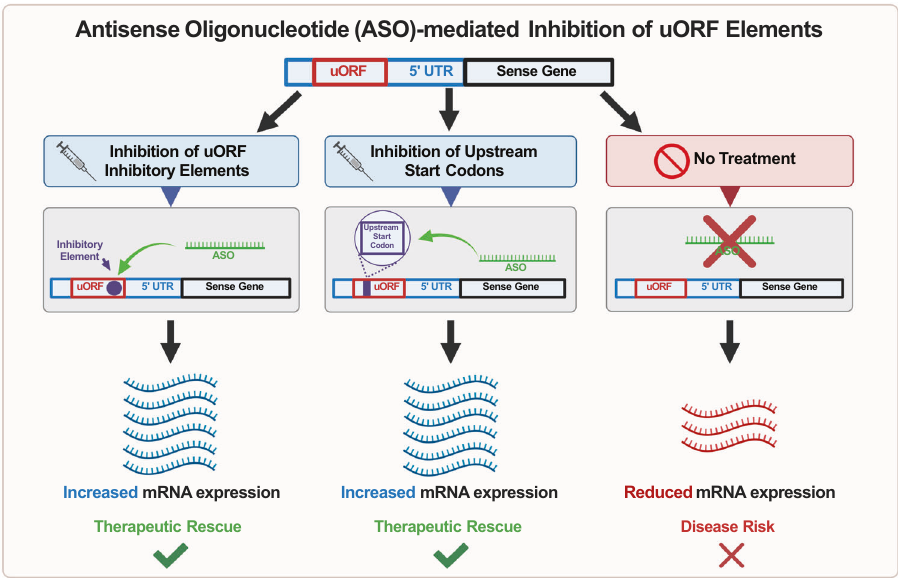
Fig. 3 Diagram of inhibitory antisense oligonucleotide (ASO) mechanisms. A ASOs can be used in the inhibition of the upstream start codon within the upstream open reading frame (uORF) of an mRNA transcript to increase translational expression of the target gene; B ASOs can be used to target and hybridize with inhibitory elements that form translation-inhibiting secondary structures within the uORF of an mRNA transcript to ultimately increase translational expression of the target gene. The reduction in mRNA expression on the far-right column is a result of the untreated haploinsuf fi cient